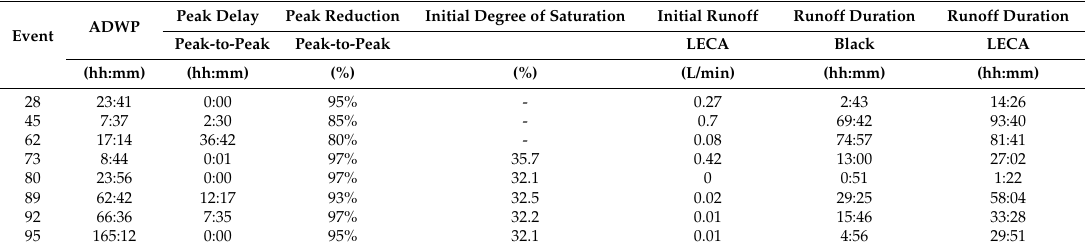
Table 3. Comparison of runoff characteristics of black and LECA-based roofs for the significant events. ADWP: antecedent dry weather